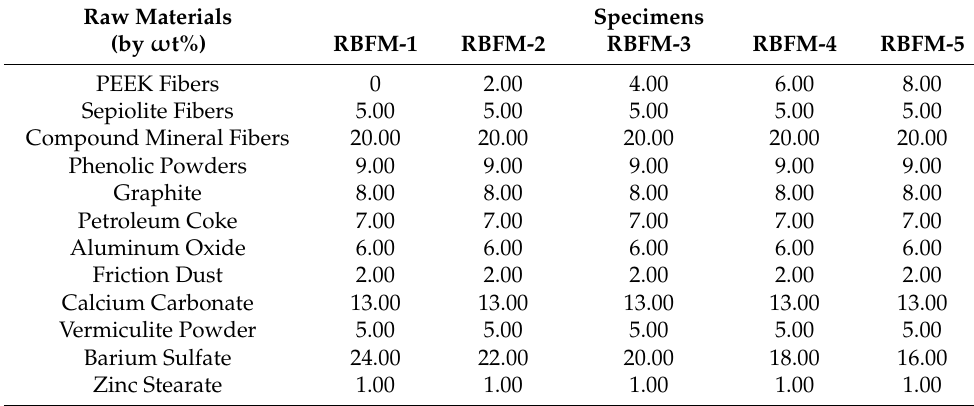
Table 1. The content of RBFM of each specimen.